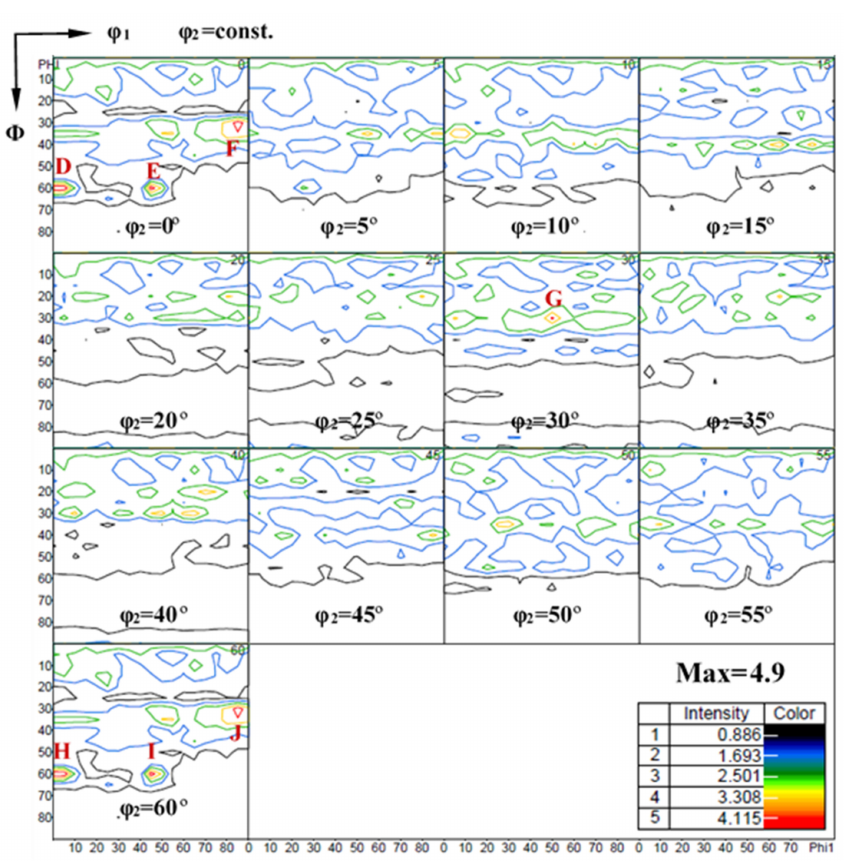
Figure 22. ODF sections of as-annealed Mg-3Y sheet (D, E, F, G, H, I and J are different texture component mark).